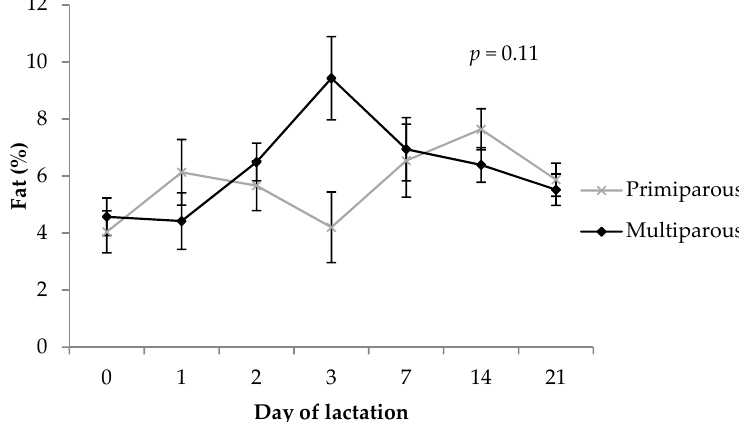
Figure 4. Comparison of total fat concentration (%) in colostrum and milk between primiparous and multiparous sows. The p- value stated is the effect of the parity by timepoint interaction. Error bars represent the standard error of the mean (± SEM).